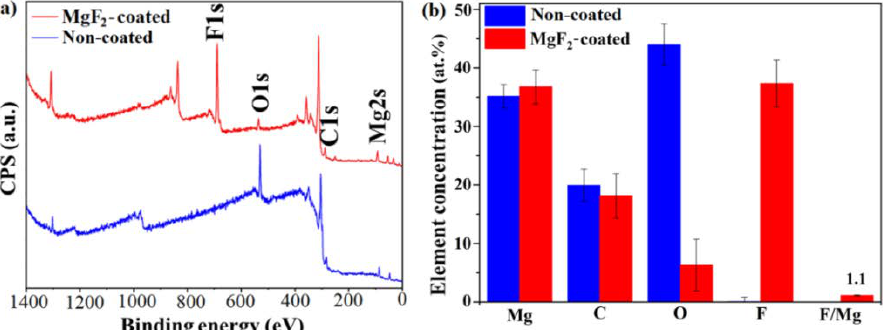
Figure 7. Survey spectra ( a ) and concentration of elements (at%), as well as F/Mg ratio ( b ), of non-coated (blue) and coated surfaces (red).